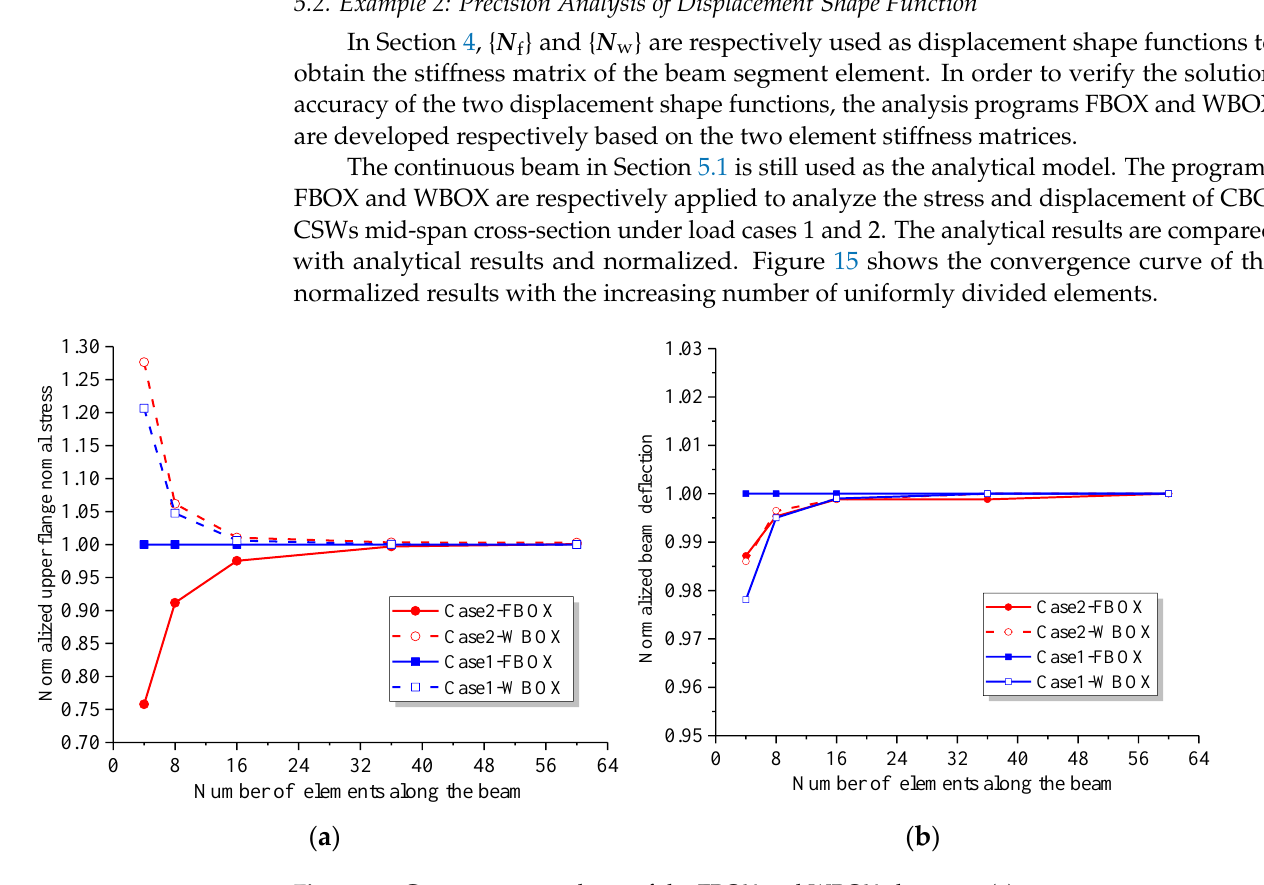
Figure 15. Convergence analyses of the FBOX and WBOX elements: ( a ) stress convergence curve; ( b ) deflection convergence curve.